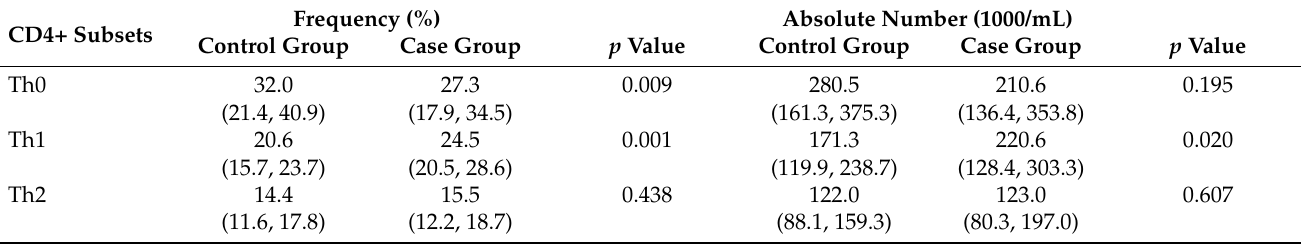
Table 2. Differences of CD4+ T-cell subsets in participants with and without